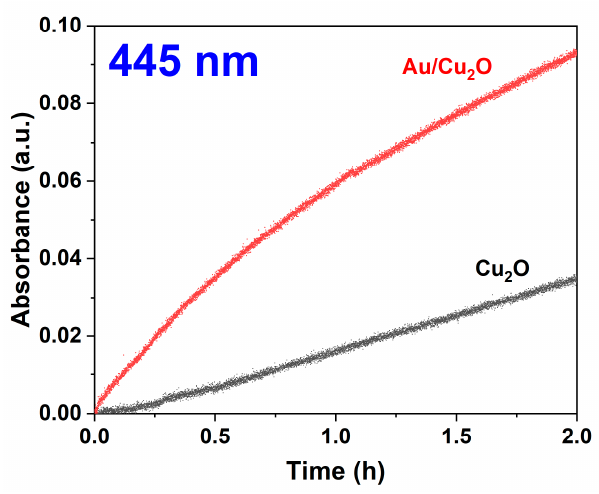
Figure 11. Azobenzene formation from aniline photooxidation under 445 nm laser excitation.